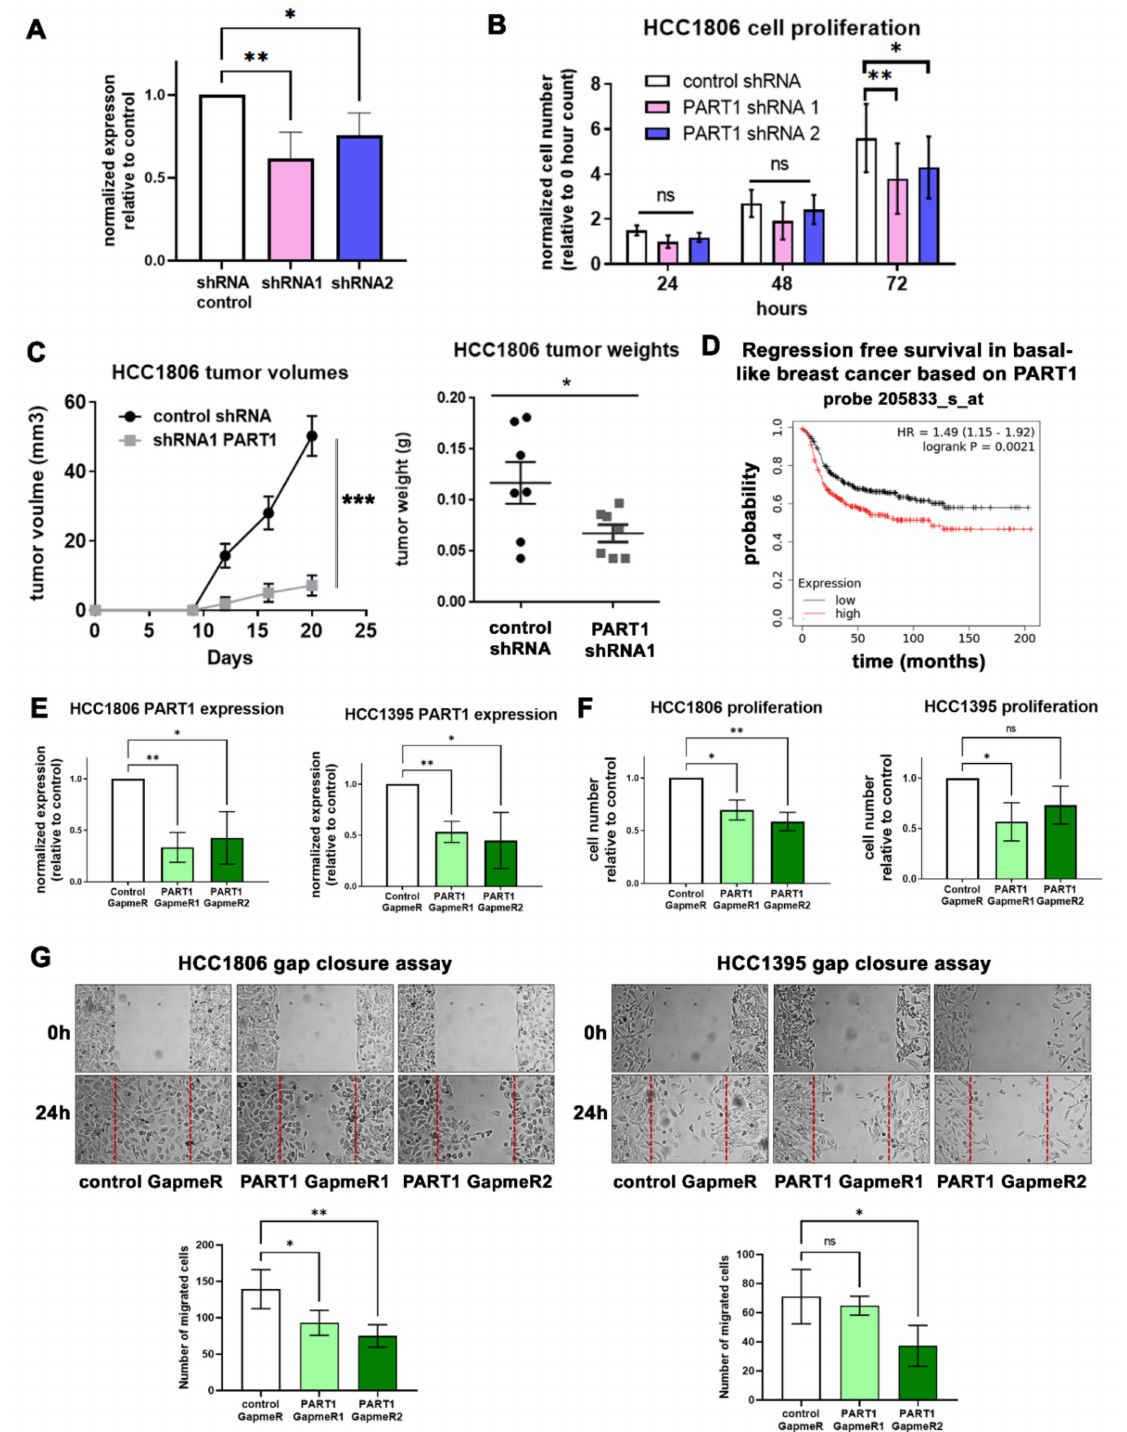
Figure 2. PART1 expression promotes proliferation, migration, and tumor growth in TNBC cells. ( A ) PART1 expression (QPCR) following shRNA-induced knockdown in HCC1806 cells ( n = 4). Expression is shown normalized to reference genes ARF1 and PUM1 and control cells. Significance was determined by a one-way ANOVA, followed by Dunnett’s post-test for multiple comparisons). Error bars represent SD. ( B ) The effect of PART1 knockdown on cell proliferation was quantified by counting the relative number of viable cells after 24, 48, and 72 h, using a trypan blue exclusion assay ( n = 5, significance determined by a one-way ANOVA, followed by Dunnett’s post-test for multiple comparisons). Error bars represent SEM. ( C ) NOD/SCID mice were injected with either 10,000 HCC1806 scramble control shRNA clones or HCC1806 PART1 shRNA